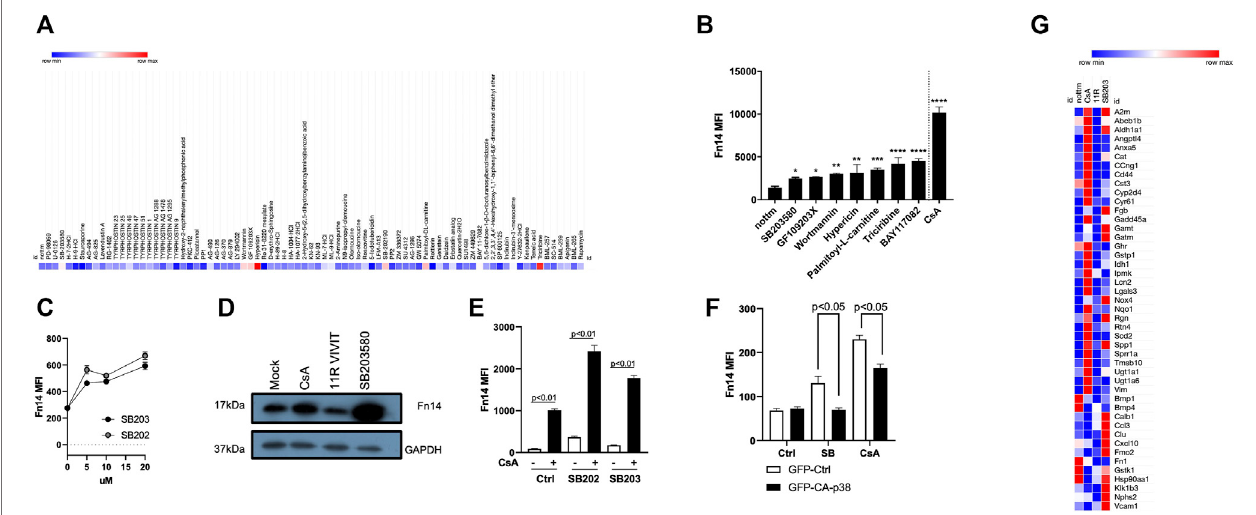
FIGURE2| EffectsofCsAonkidneyepithelialcellsaremimickedbyproteinkinaseinhibitors. (A-B) ProteinkinaselibraryscreenrevealedthatinhibitionofPI3K/Akt, IKK, and p38 MAPK induces Fn14 (MCT). (C) Titration of two p38 MAPK inhibitors (SB203580 and SB202190) revealed the similar potential to induce Fn14 (MCT). (D) Protein levels of Fn14 are increased upon CsA and SB203580 treatment but not when NFAT is inhibited (MCT, Western Blot). (E) Increased expression of Fn14 is detected when cells are treated simultaneously with the p38 MAPK inhibitor and CsA compared to single treatment with inhibitors (MCT cells). (F) Constitutive activep38MAPKshowsreducedFn14expressiononcellswhentreatedwitheitherSB203580orCsA(HEK293T). (G) NephrotoxicgenesareupregulatedwithCsAand with SB203580 (MCT, RT-PCR). If not indicated differently, results were acquired by fl ow